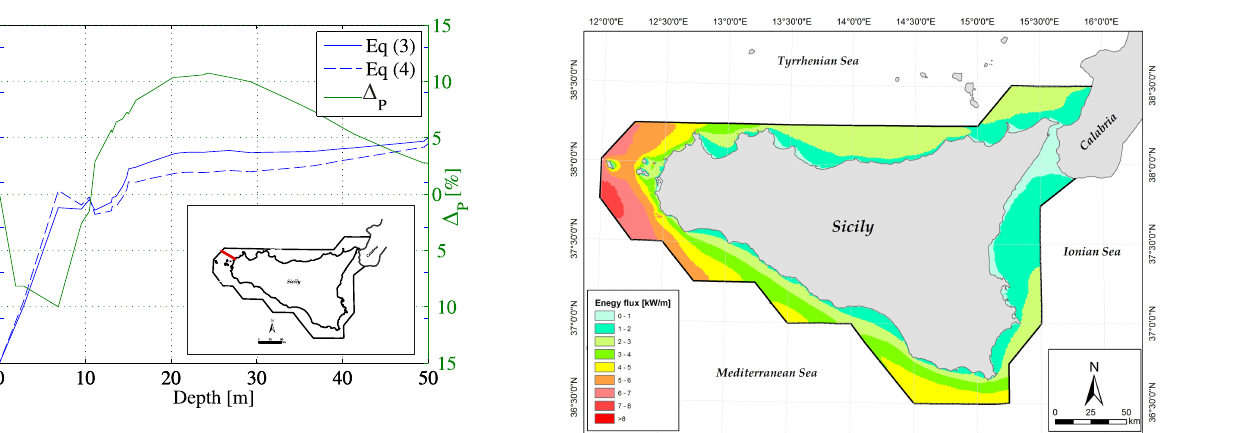
Figure 7. Comparison between Eqs. (3) and (4) along the red line indicated in the map for a case study: offshore significant wave height in the nearest boundaries of approximately of 2m with a mean period of 10s.